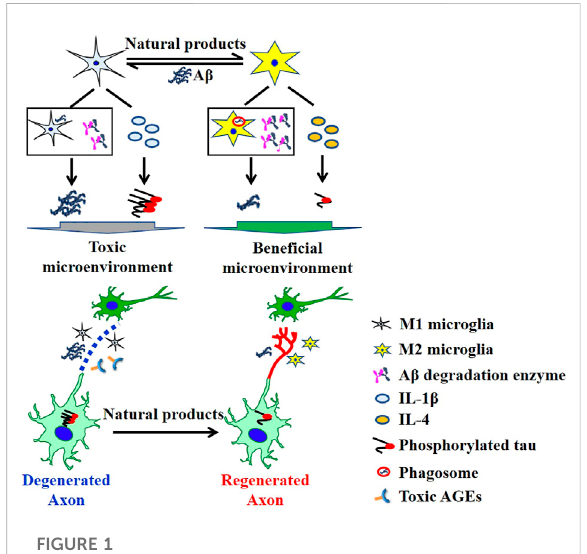
FIGURE 1 Neurite regenerative strategy as potential AD